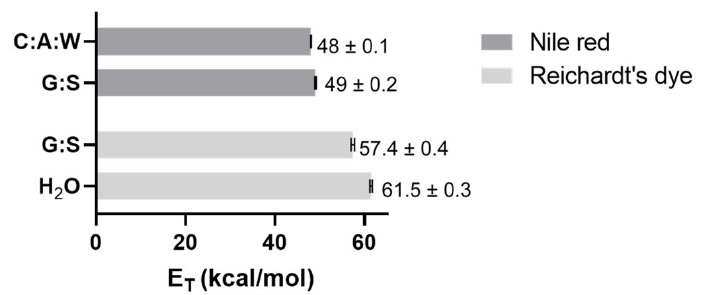
Figure 7. E T values obtained for C:A:W, G:S, and H 2 O using Nile red and/or Reichardt’s dye.